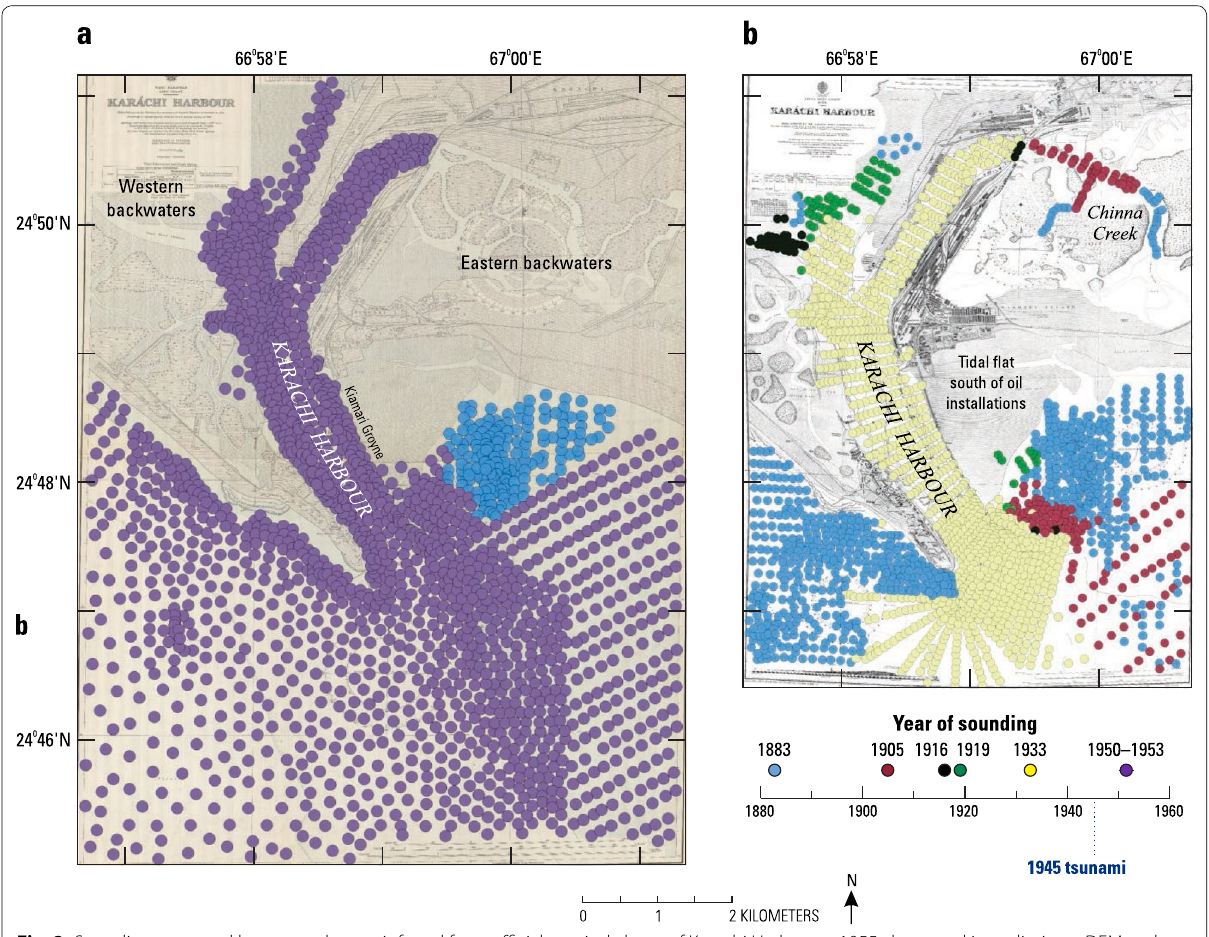
Fig. 2 Soundings grouped by survey date, as inferred from official nautical charts of Karachi Harbour. a 1955 chart used in preliminary DEM